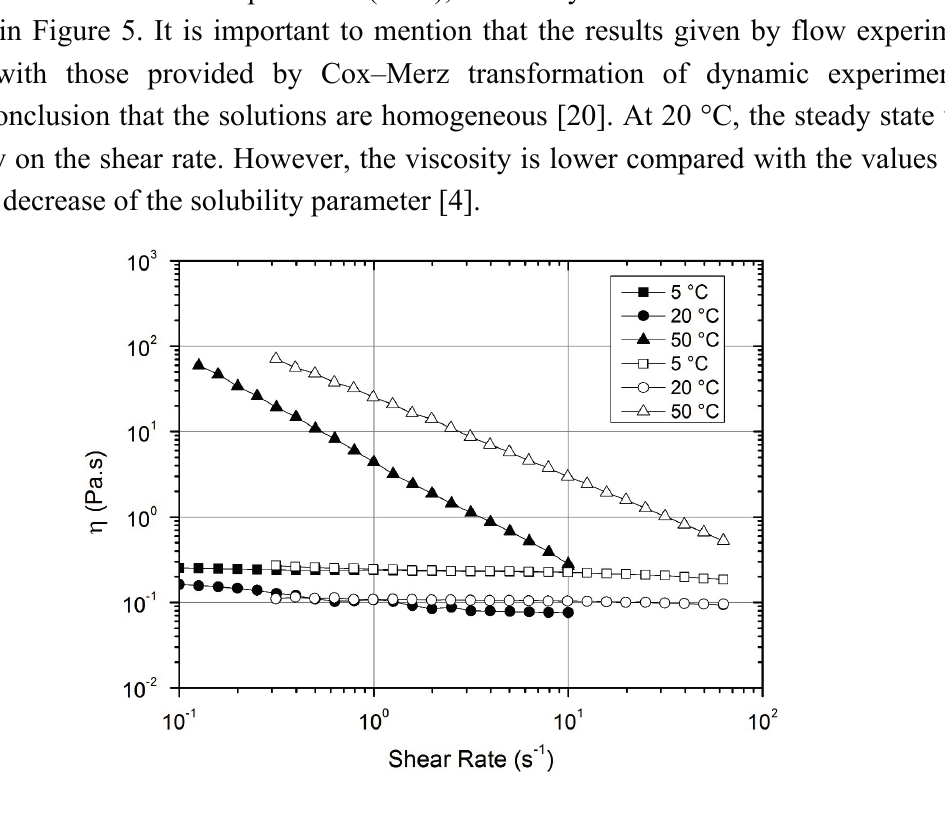
Figure 5. Viscosity as a function of the shear rate for methylcellulose A15C at 10 g/L. Open symbols are given for Cox–Merz transformation of dynamic measurements, filled symbols are for flow measurements. The lines are added to guide the